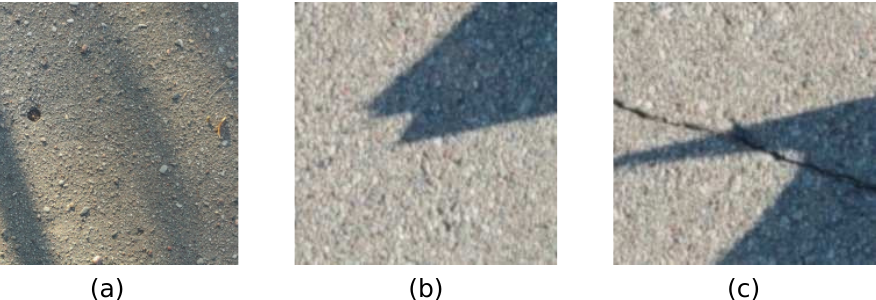
Figure 1. Sample images of concrete surfaces in the presence of shadows. Parts ( a , b ) show concrete surfaces without cracks. Part ( c ) shows concrete crack surface with